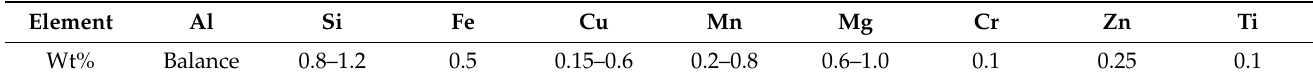
Table 1. AA6010 chemical composition in wt% [18].